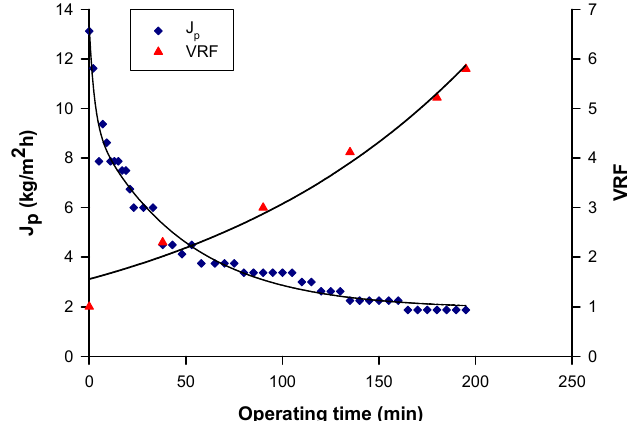
Figure 5. Clarification of goji leaf aqueous extract by ultrafiltration. Time course of permeate flux and VRF (TMP: 0.7 bar; Q f : 150 L/h; T: 26 ± 1 °C).